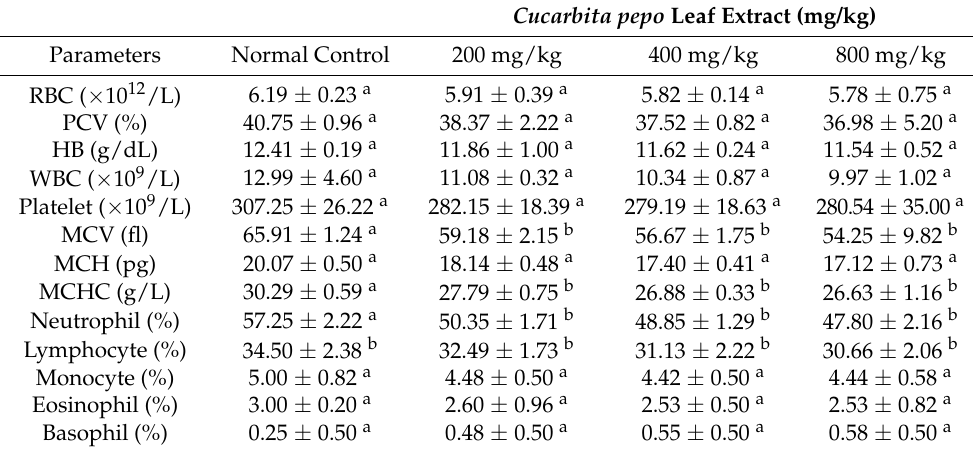
Values represent the mean ± SD for n = 6. Values in the same row bearing the same letter of the alphabet are not significantly different from each other ( p > 0.05). RBC, Red Blood Cells; PCV, Packed Cell Volume; HB, Haemoglobin; MCV, Mean Corpuscular Volume; MCH, Mean Corpuscular Haemoglobin; MCHC, Mean Corpuscular Haemoglobin Concentration; and WBC, White Blood